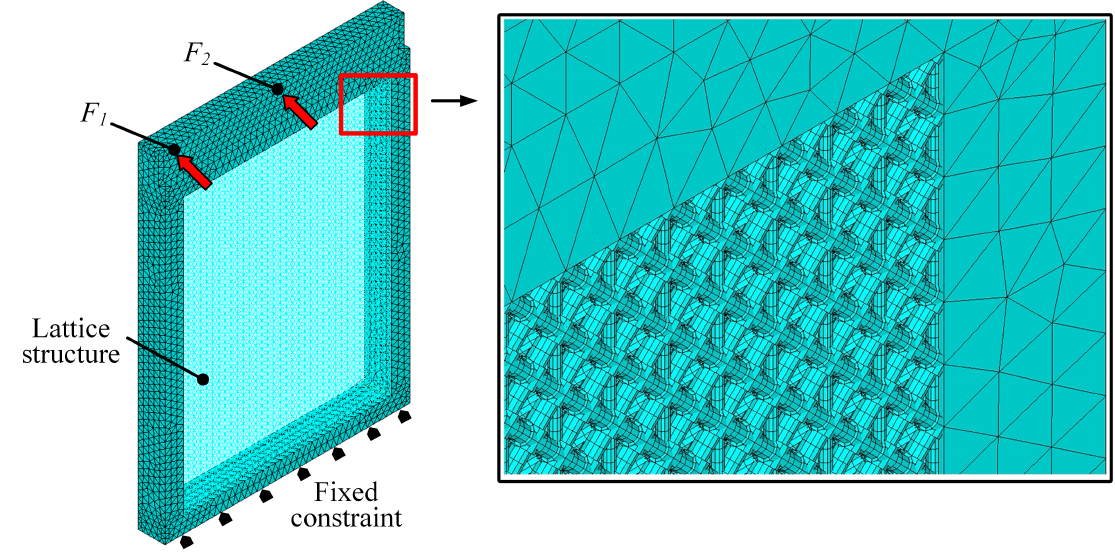
Figure 7. Blade like support mesh, constraints, and loads.